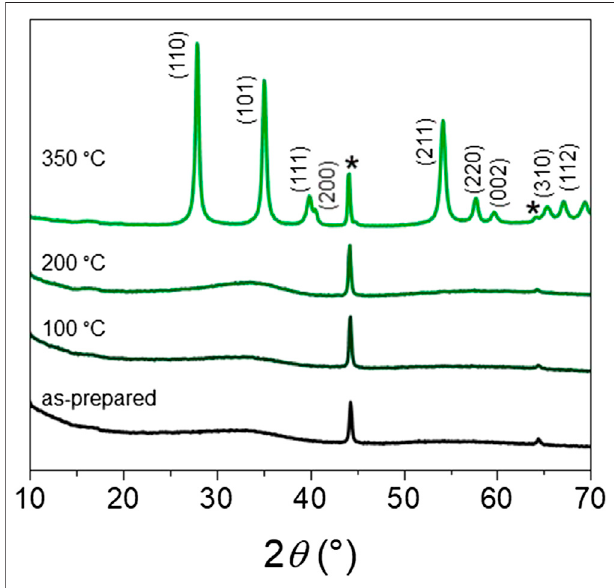
FIGURE 2 | In situ XRD pattern of H-RuO 2 calcined at different temperature under air atmosphere (*sample